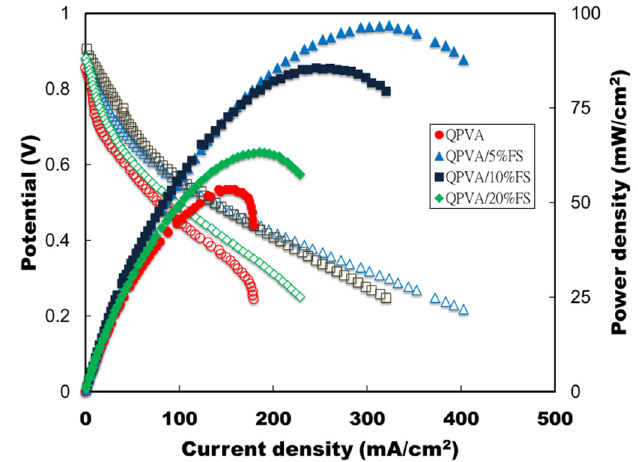
Figure 12. Methanol cell performance of pristine QPVA and QPVA/FS nanocomposite membranes at 80 °C.